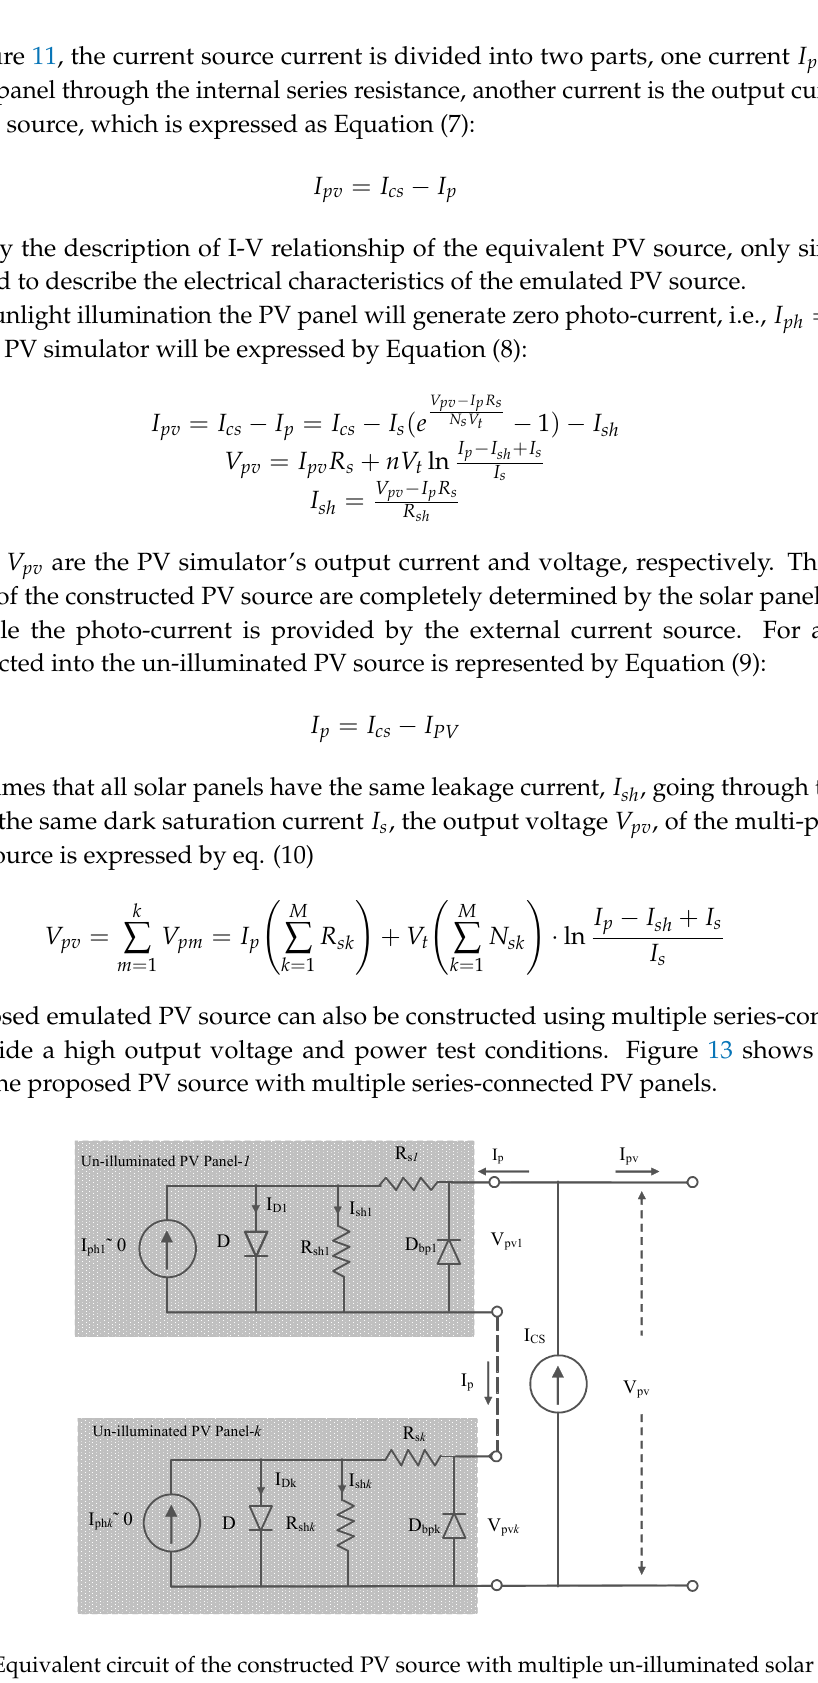
Figure 13. Equivalent circuit of the constructed PV source with multiple un-illuminated solar panels connected in series.